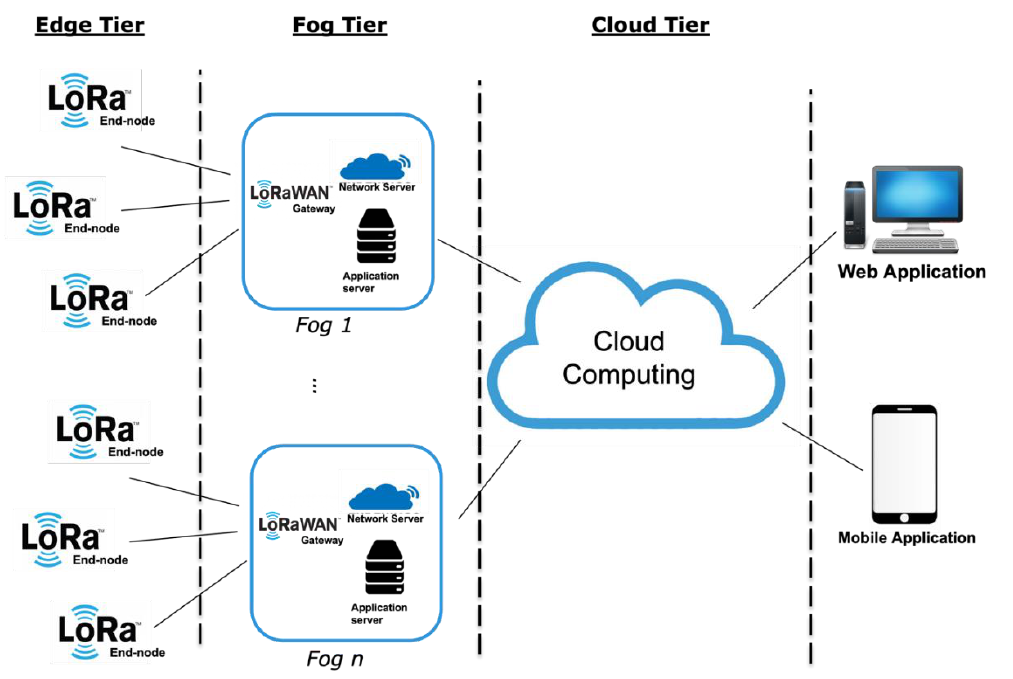
Figure 4. LoRaWAN Fog-Tier Architecture.